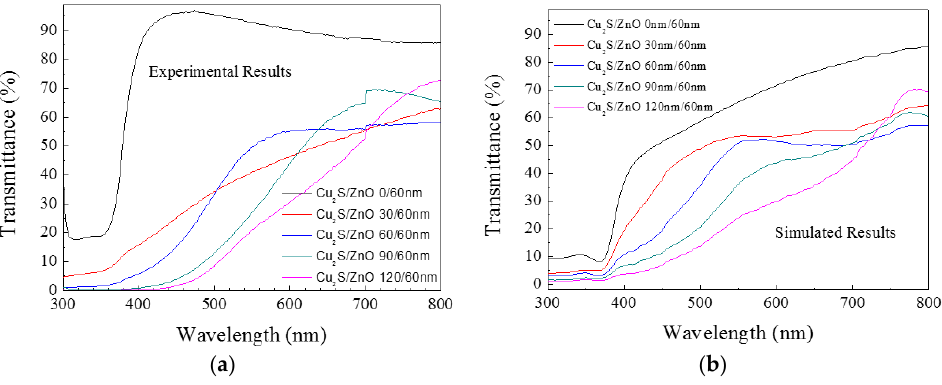
Figure 20. ( a ) is experimental results of Cu 2 S/ZnO/glass film and ( b ) is simulated results of Cu 2 S/ZnO/glass film.